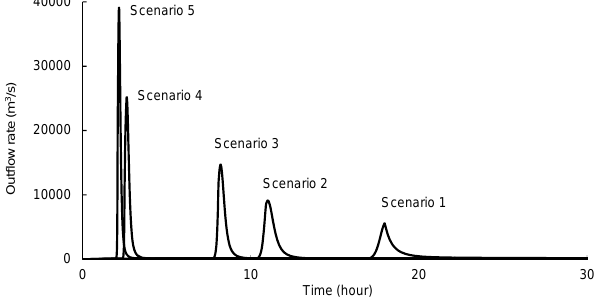
Fig. 10. Outflow rates in the five scenarios of stage 2.